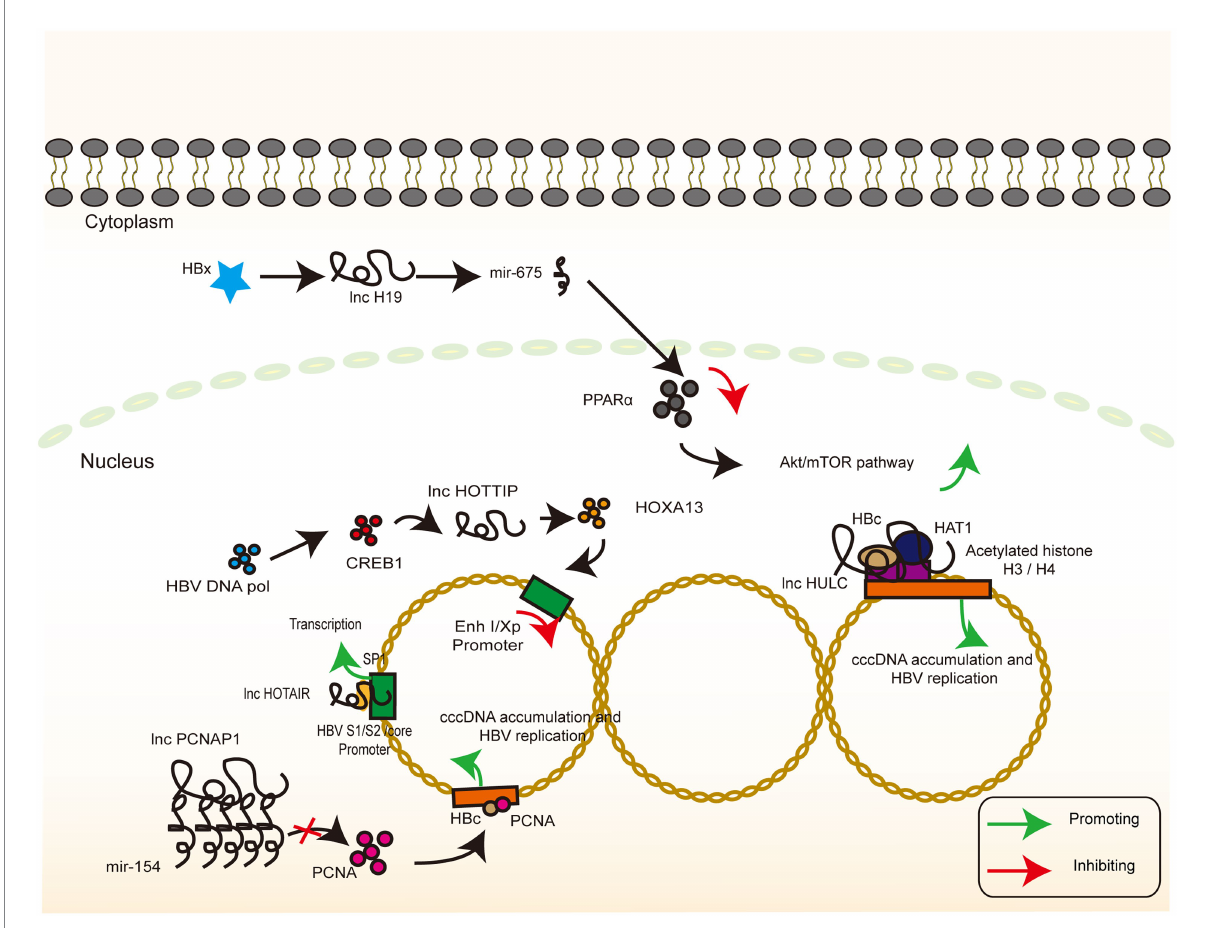
FIGURE 4 lncRNAs targeting HBV genome. The signaling pathway of IFN-related lncRNA whose target of action is located in the HBV genome. Colour blocks indicate different molecules, irregular lines indicate ncRNA (both lncRNA and miRNA), and large circular lines indicate HBV cccDNA. Green arrows indicate the upregulation, while red arrows indicate the